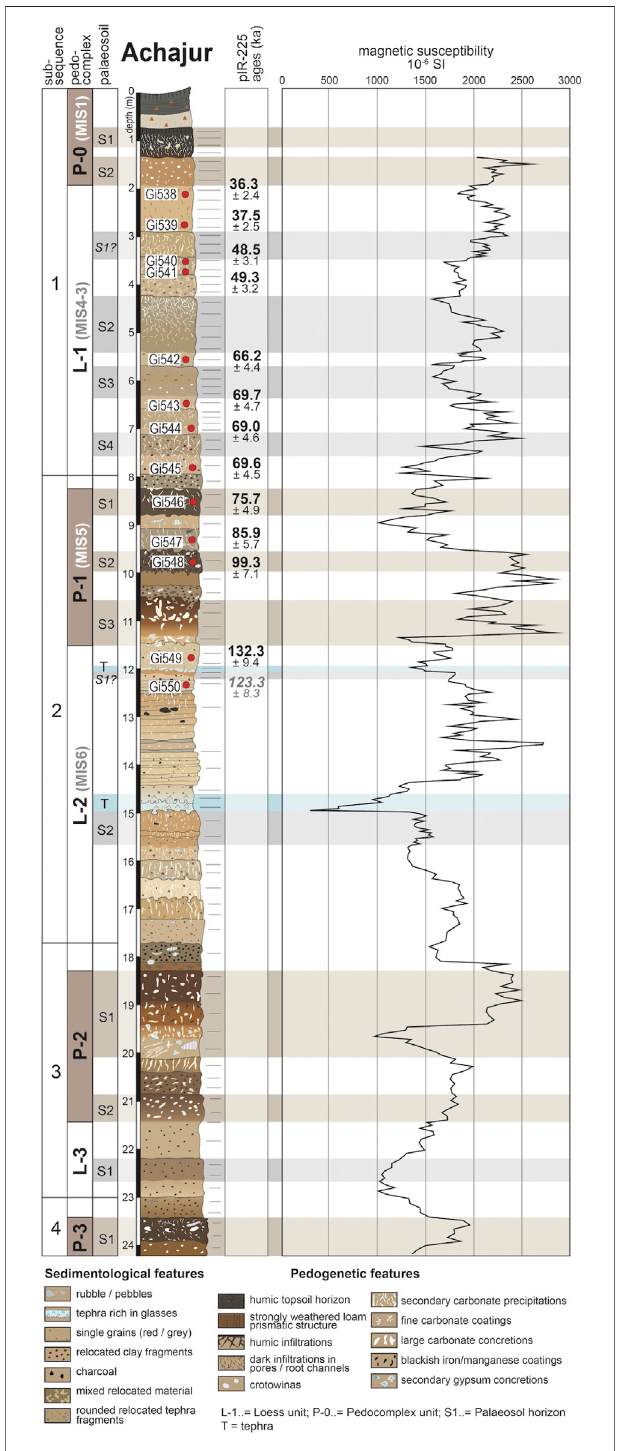
FIGURE 2 | Loess section Achajur with pIRIR-225 ages. The age of Gi550 is set in italics, because it likely underestimates the true depositional age. Magnetic susceptibility ( χ ) measurements were carried out with a portable Bartington susceptibility meter at an interval of 5 cm.